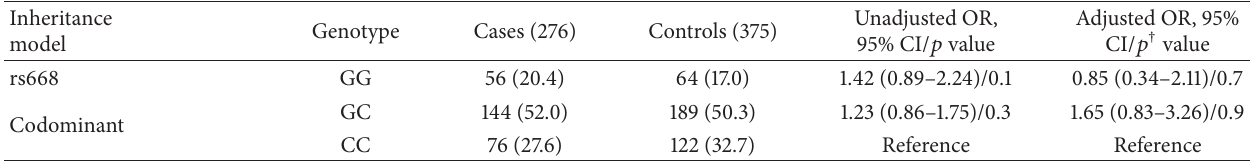
Table 3: Logistic regression analysis adjusted for different confounders (duration of hypertension, systolic blood pressure, CVD, diabetic retinopathy, diabetic foot, HbA1c, fasting glucose, urea, creatinine, cystatin C, and urine albumin/creatinine ratio) according to codominant genetic model.